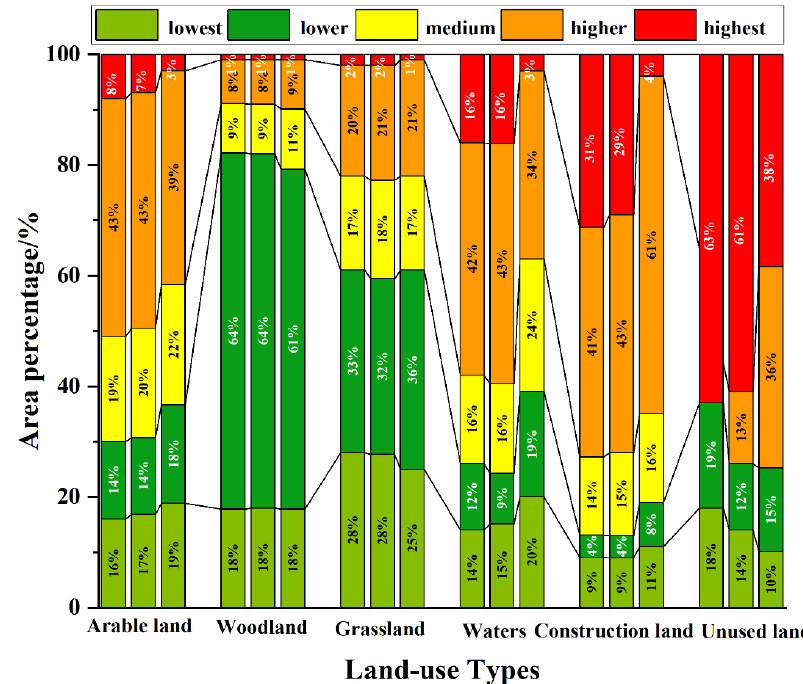
Figure 6. Distribution of ecological risks in different land-use types.